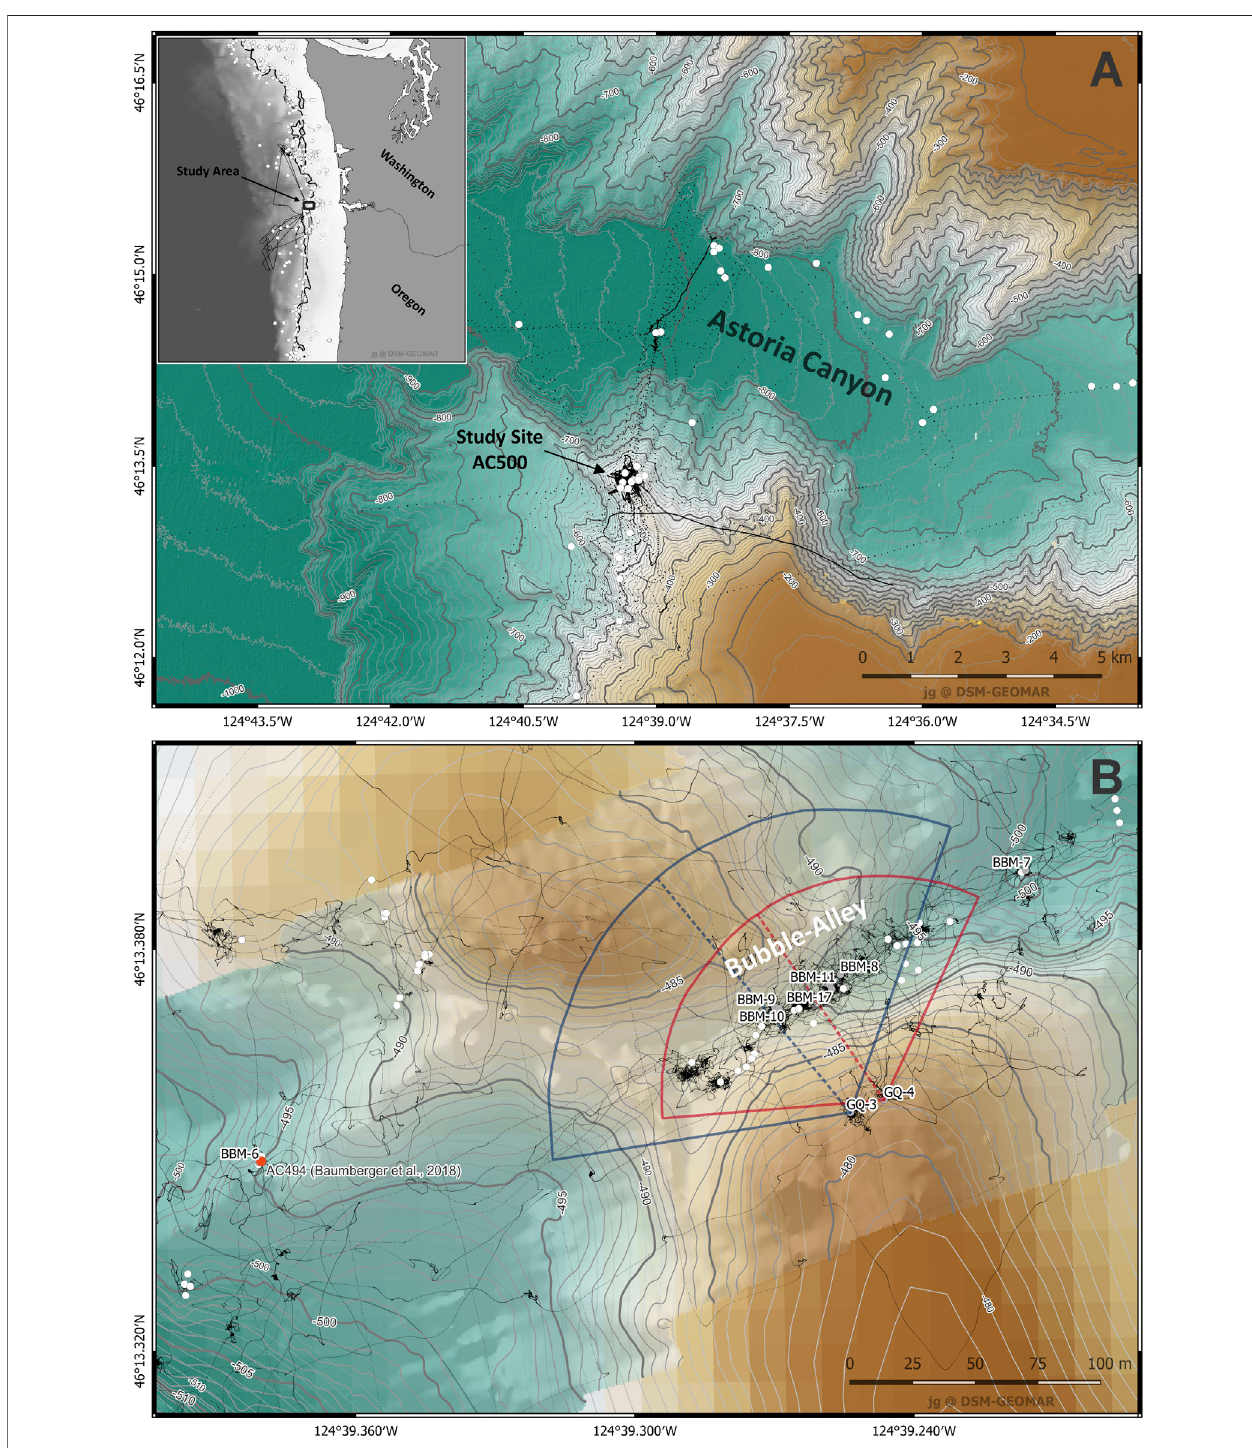
FIGURE 1 | (A) Bathymetric map of the Astoria Canyon area, with the Study Site AC500 on the ridge crest as part of the southern canyon fl ank. White circles indicate active seep sites detected during MBES surveys from several cruises. Small black spots indicate the cruise track of RV FALKOR. Previously sample seep locationsbyBaumbergeretal.(2018)aregiven(bathymetricdatacourtesyoftheUSGS). (B) DetailedmapoftheAC500site;bathymetricdatahavebeenacquiredusing the GasQuant Imagenex MBES mounted on the ROV during a mapping survey (Dive 272). All BBM sites are indicated; BBM-11 and BBM-17 locations were close to each other in the middle of the Bubble-Alley. (A,B) White dots indicate bubble locations that were annotated during the dives (not all locations are shown), and small black dots are ship (A) and ROV tracks (B) .